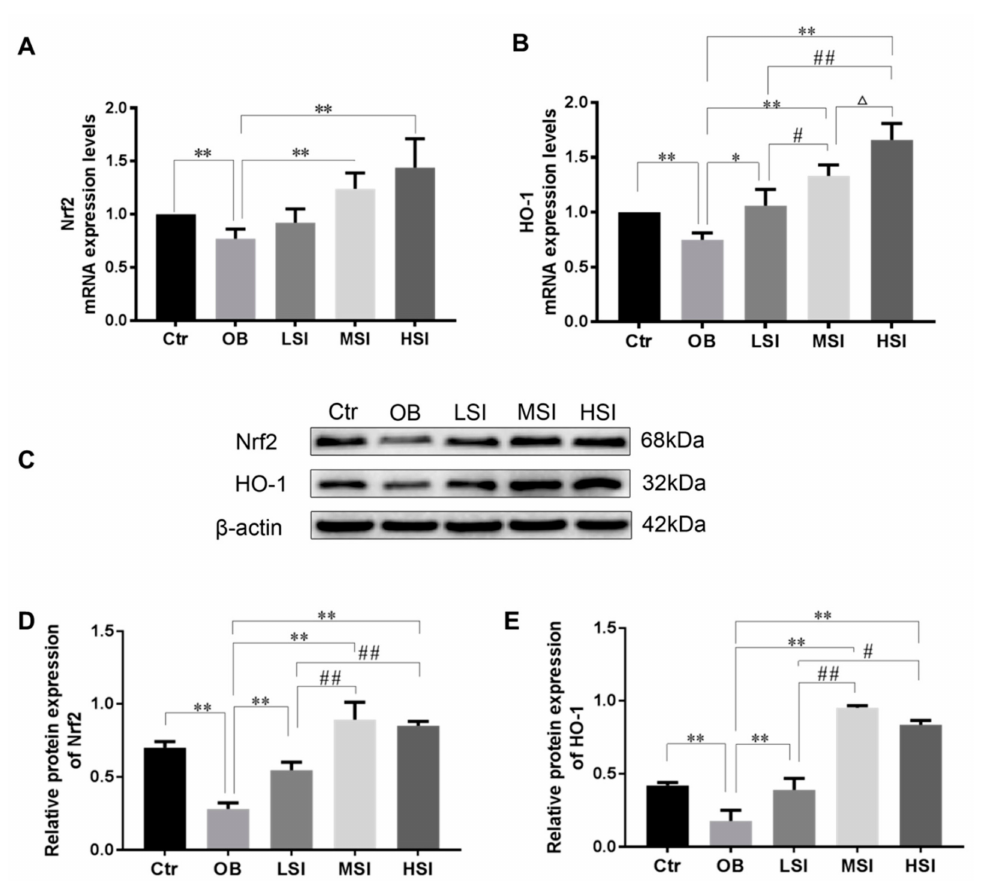
Figure 5. SIF treatment resulted in the activation of Nrf2 / hemeoxygenase 1 (HO-1). ( A , B ) represent mRNA expression level of Nrf2 and HO-1 in the indicated groups ( n = 8). ( C ) represents western blotting (WB) banding pictures of Nrf2 and HO-1. ( D , E ) represent protein expression levels of Nrf2 / HO-1 in the testis tissue of the indicated groups ( n = 8). Bars represent the mean ± SD, * p < 0.05, ** p < 0.01 vs. OB; # p < 0.05, ## p < 0.01 vs. LSI; ∆ p < 0.05, ∆∆ p < 0.05 vs. MSI, one-way ANOVA analysis and LSD